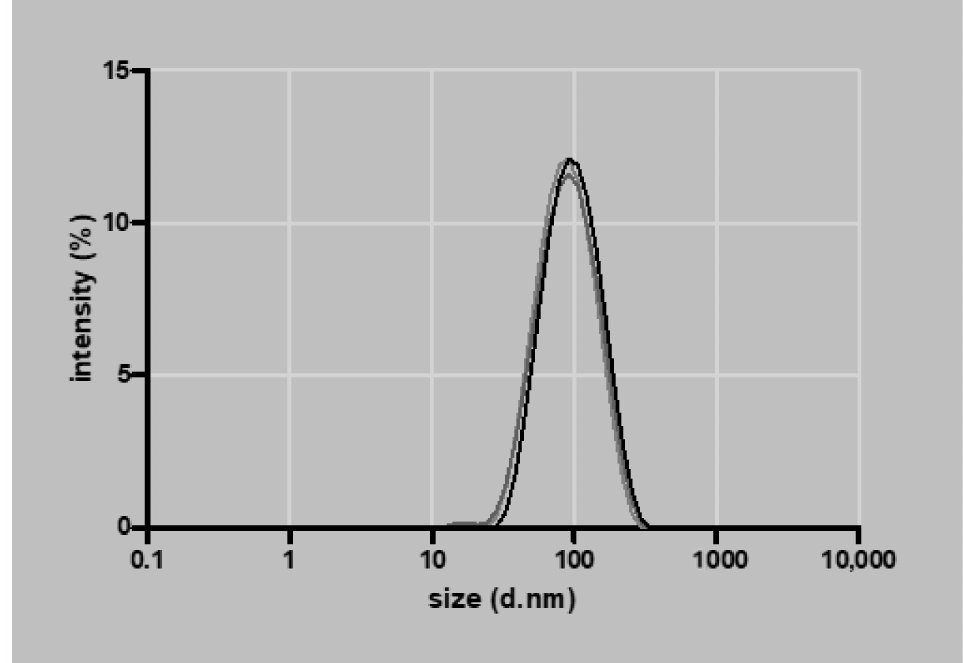
Figure 2. Particle size distribution measured by % intensity and particle diameter expressed in nanometer (d.nm; n =